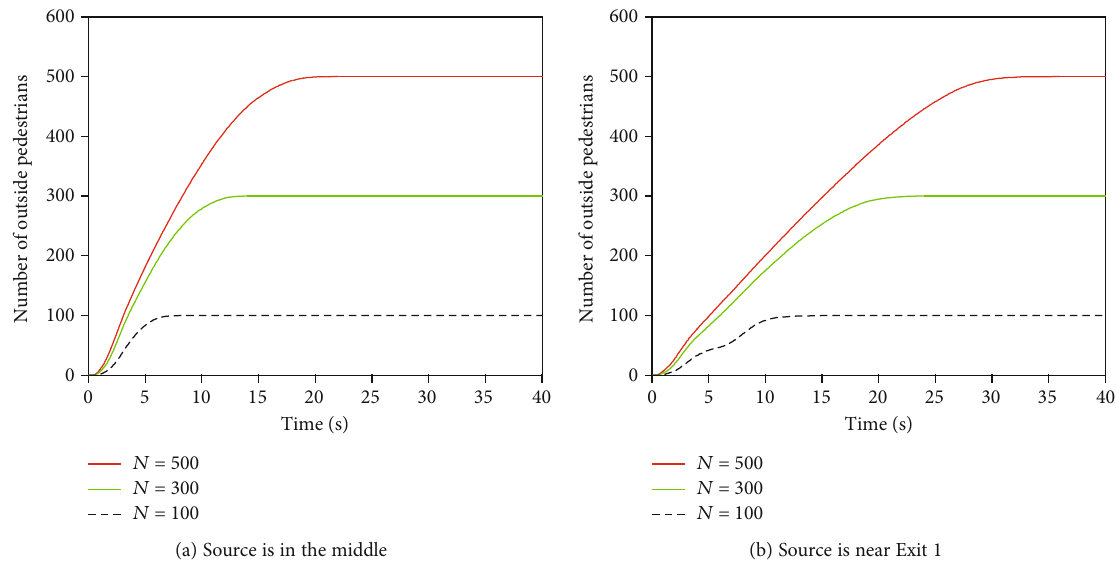
Figure 3: Average number of outside pedestrians in scenario (i) and scenario (ii). The number of pedestrians is 100, 300, and 500. Table 3: The computation time of ten trial runs in scenario (i) and in scenario (ii) with 100, 300, and 500